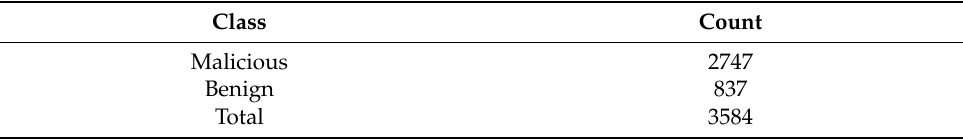
Table 2. Composition of the dataset after static